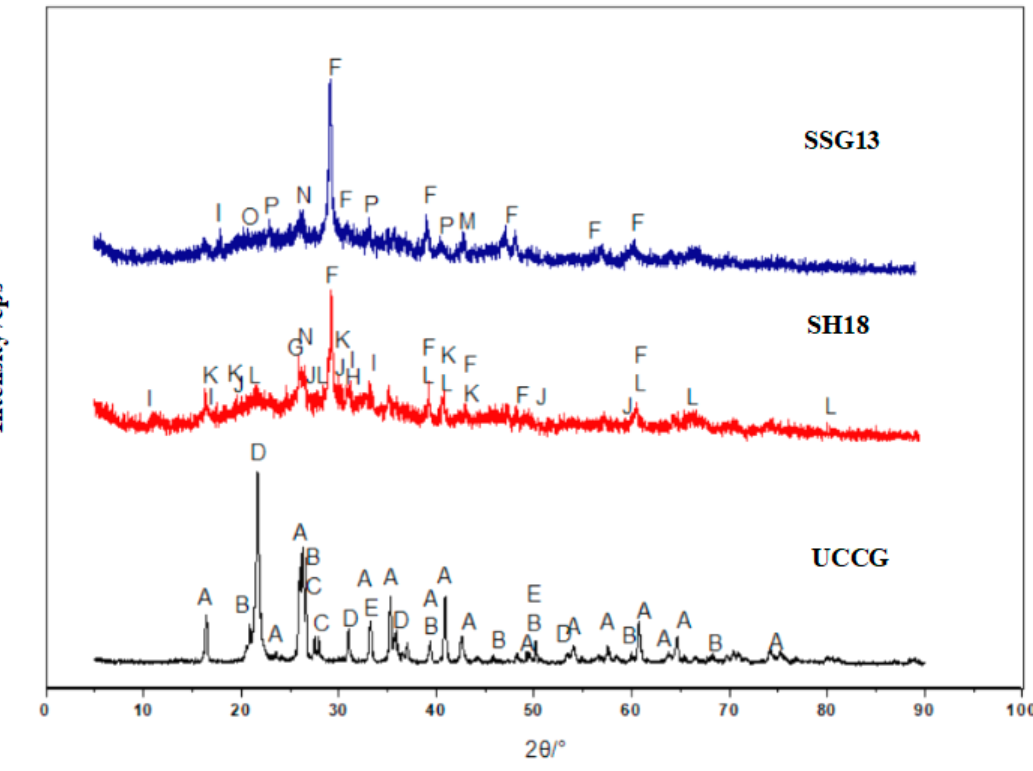
Figure 12. XRD patterns of UCCG and geopolymer. A: Sillimanite, B: Quartz, C: Kyanite, D: Cristobalite, E: Hematite, F: Calcite, G: Analcime, H: Gehlenite, I: zoisite, J: Gonnardite, K: Thomsonite, L: Mesolite, M: Nepheline, N: kyanite, O: Gypsum, P: Anorthite.